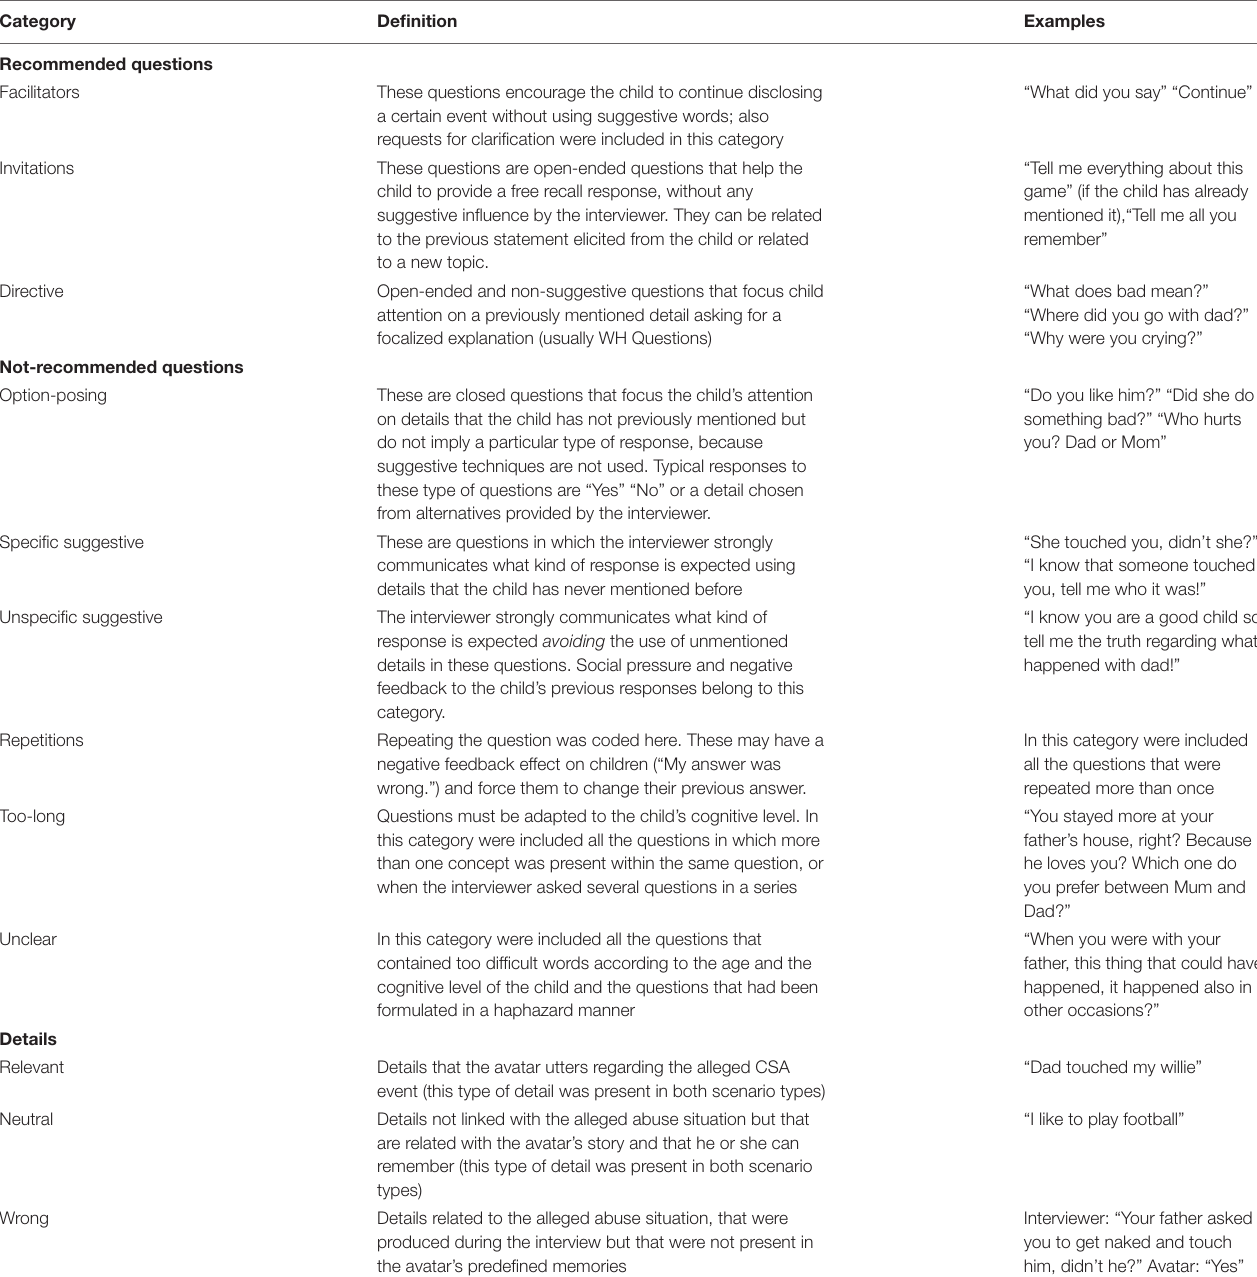
TABLE 1 | Description of question-types and details coding used for the